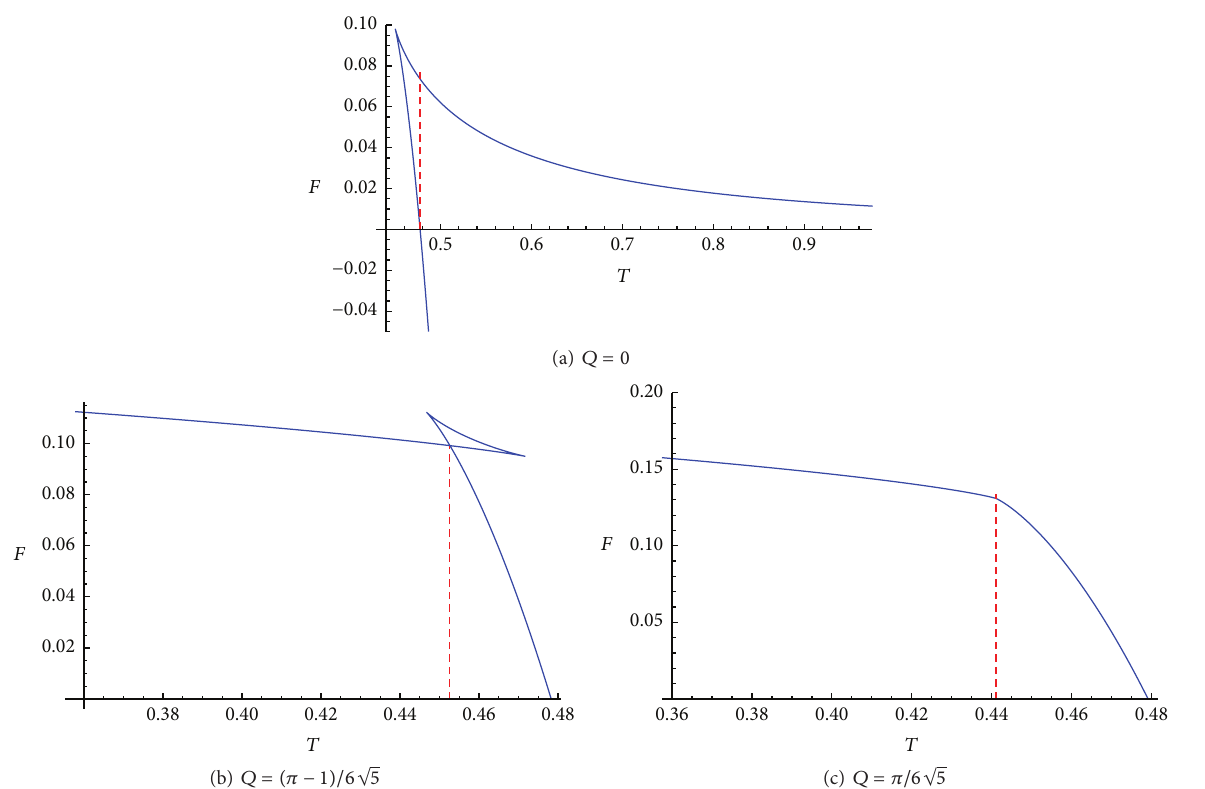
Figure 2: Relation between the free energy and temperature for different charges. The horizontal coordinates of the red dashed lines correspond to the temperatures of the Hawking-Page phase transition, first-order phase transition, and second-order phase